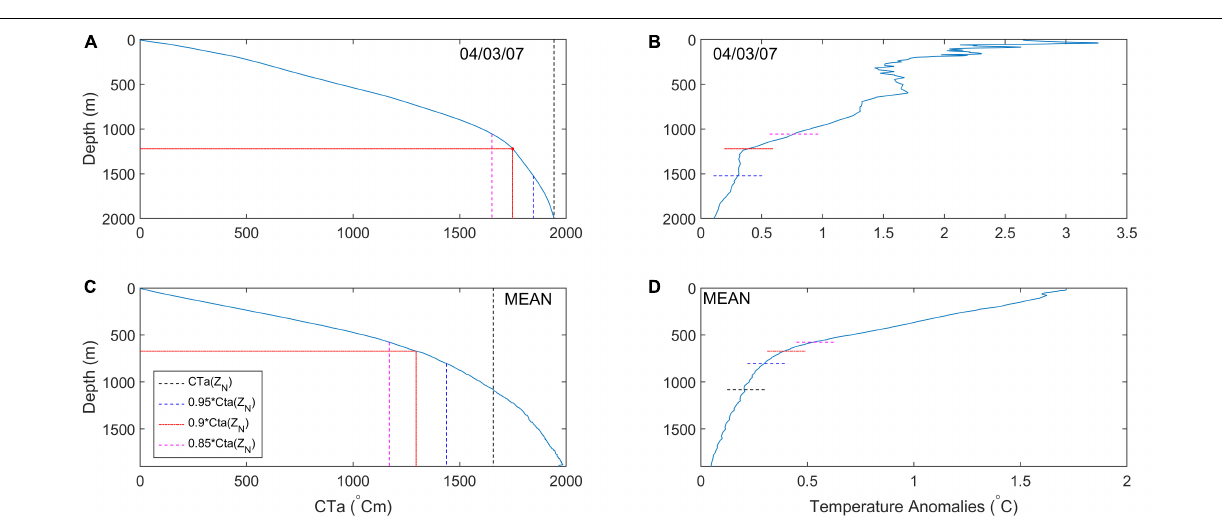
FIGURE 3 | Illustration of different estimates of the MHW depth for a specific Argo profile (top row) with corresponding date of observation and the mean over all MHW profiles (bottom row). Panels (A,B) show the cumulative temperature anomaly (CTa) and the MHW depth obtained at ε = 0.95 (blue dotted line), 0.9 (red dotted-dashed line) and 0.85 (magenta dotted line). Panels (B,D) show the profiles of temperature anomaly and the corresponding MHW depth obtained using the CTa cut-offs at the same ε